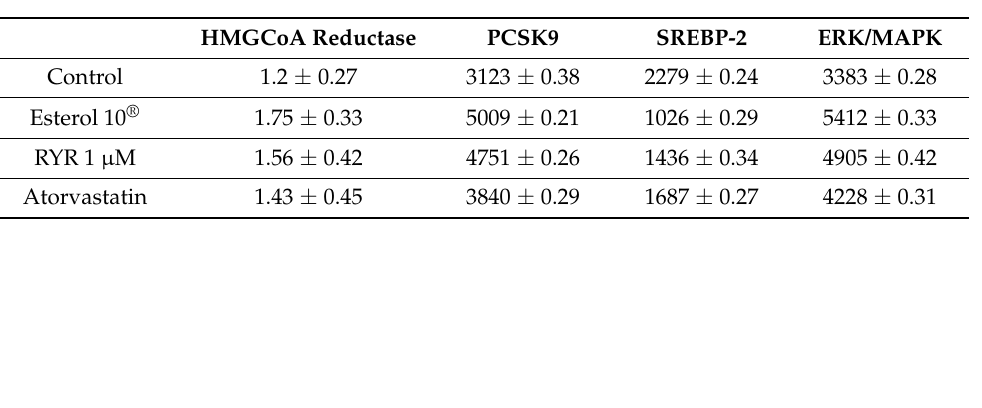
Table A1. Original data of HMGCoA, PSK9, SREBP-2, and ERK/MAPK activity on HepG2 cells. RYR = Red Yeast Rice. Data are mean ± SD of five independent experiments performed in